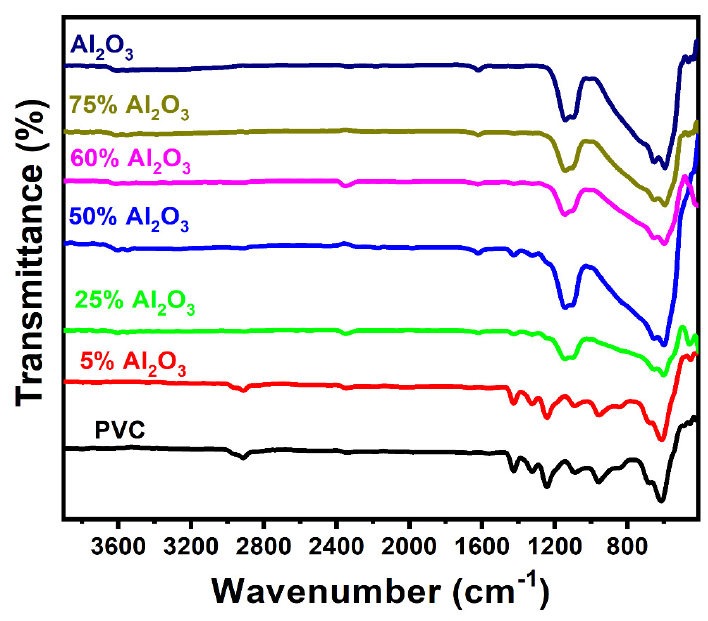
Figure 3. FT-IR spectra of pure Al 2 O 3 , PVC, and Al 2 O 3 /PVC samples containing different aluminum trioxide amounts .